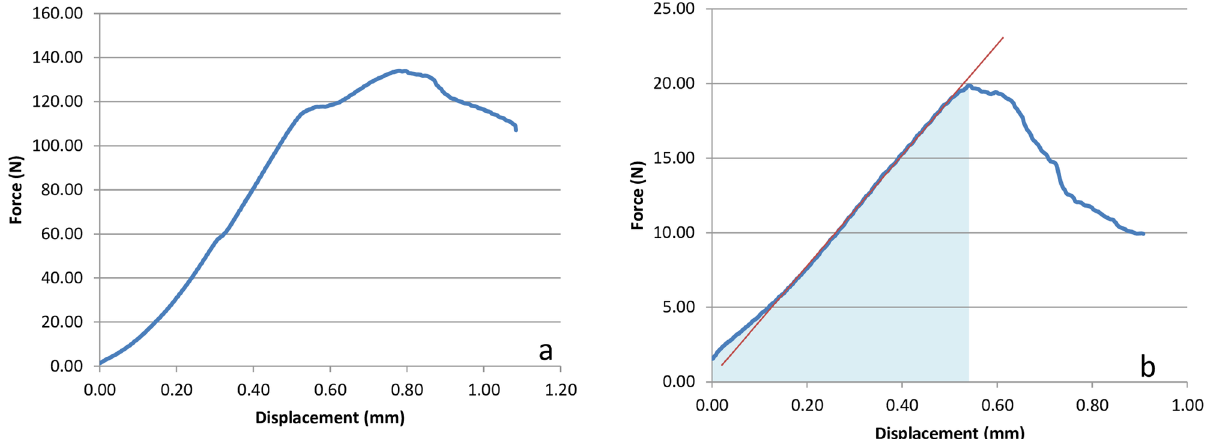
Fig 2. Biomechanical Parameters. (a, b) Load-displacement diagram of corresponding bones during three-point bending. The first diagram (a) shows the fracture-curve of the control side, the second the experimental side (b). The ordinate displays the force (N), the abscisse the displacement (in mm). Different scales of the ordinate. The red line in Fig 2b displays stiffness (gradient of the linear part of the load-displacement curve). The light blue area is the work to failure (area under the curve (Nmm)).